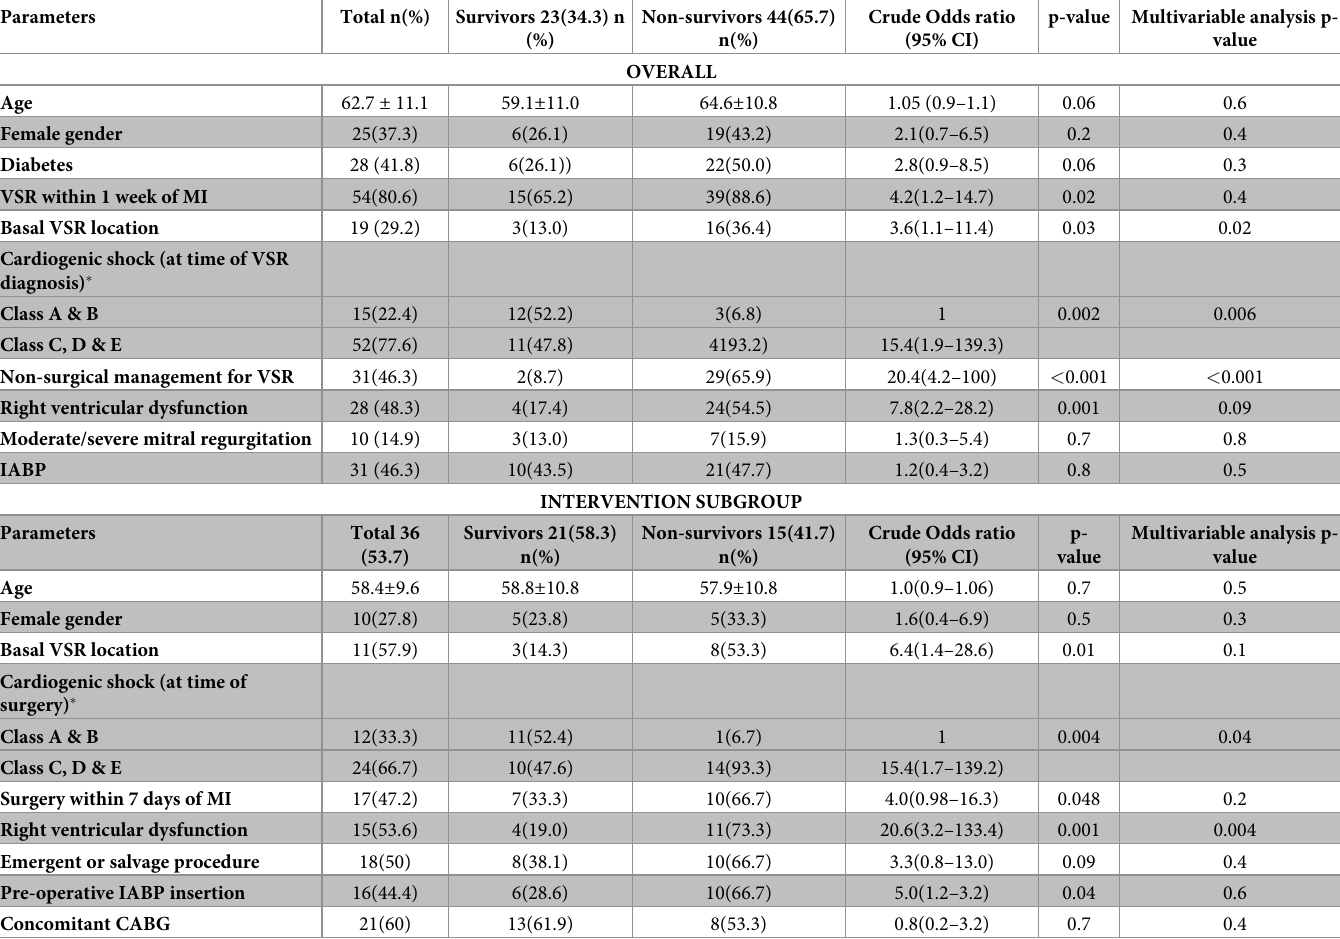
Table 2. Univariate and multivariable analysis of covariates for hospital mortality $